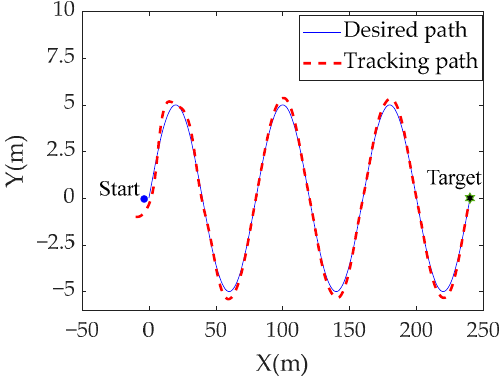
Figure 11. Path-tracking results for the sine curve.